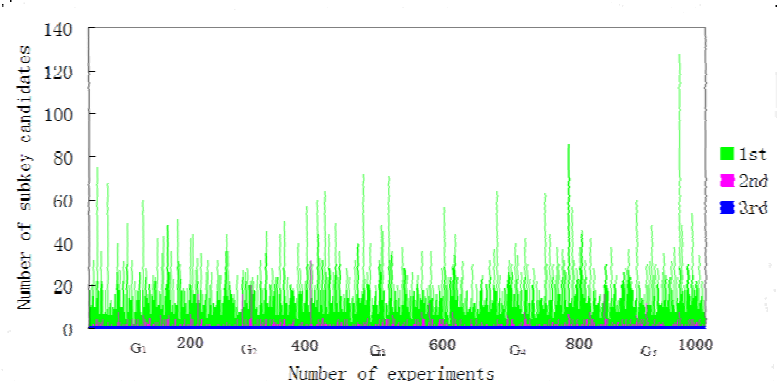
Fig. 4 (color) Three intersections of subkey candidates in the 1000